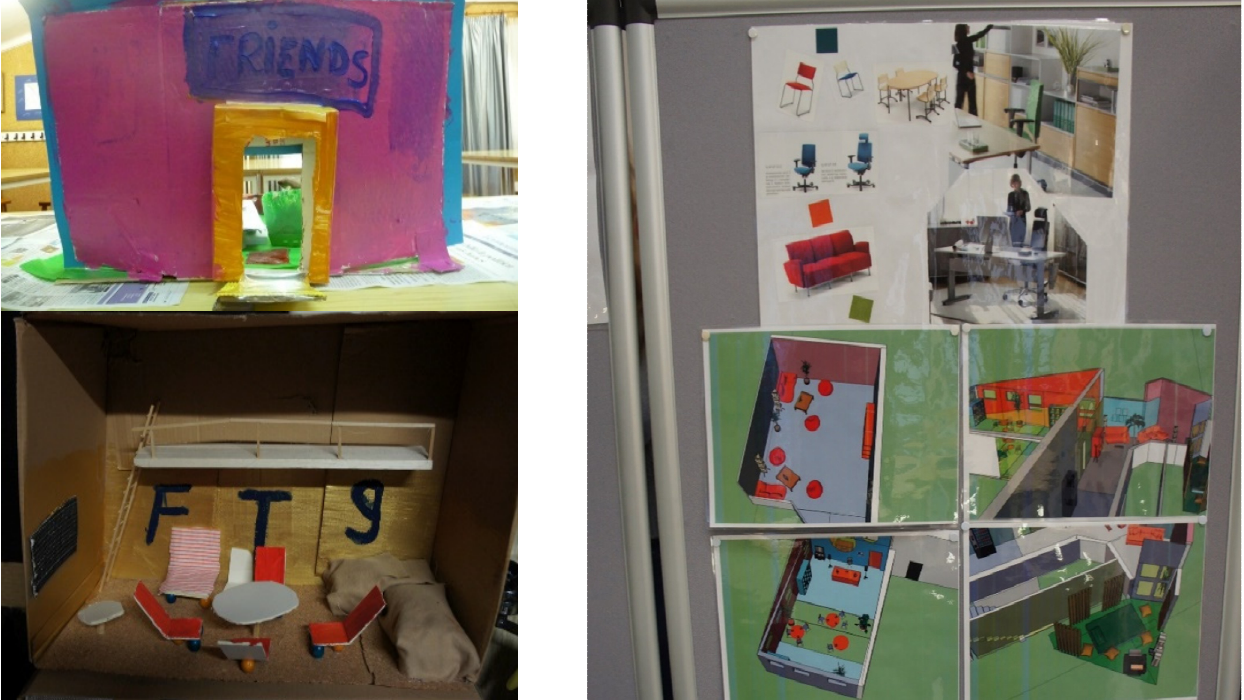
Figure 3. Examples of designs by Spanish 3rd graders ( upper left ), Finnish 8th graders ( down left ), and upper secondary school students ( right